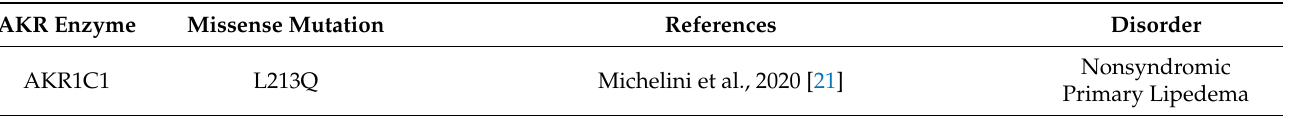
Table 1. Familial inherited missense mutations in steroid transforming human AKRs.